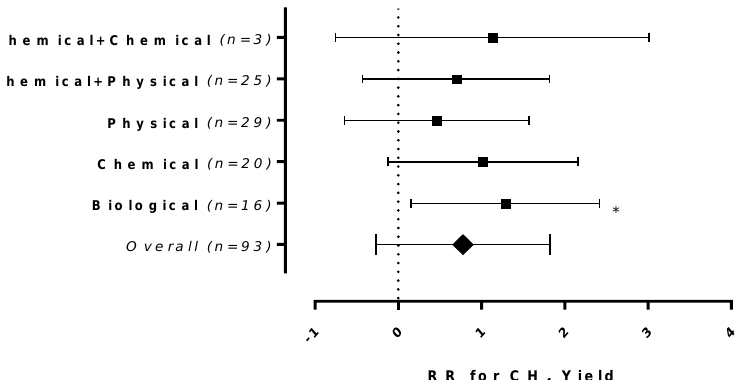
Figure 3. Effect size by natural log response ratio (RR) of methane yield with 95% confidence interval (CI) ( p -value = 0.05), comparing the performance of the biological, chemical, physical, chemical + physical, and chemical + chemical pretreatments. Significant code p ≤ 0.05 (*); n = number of effect sizes per treatment type.